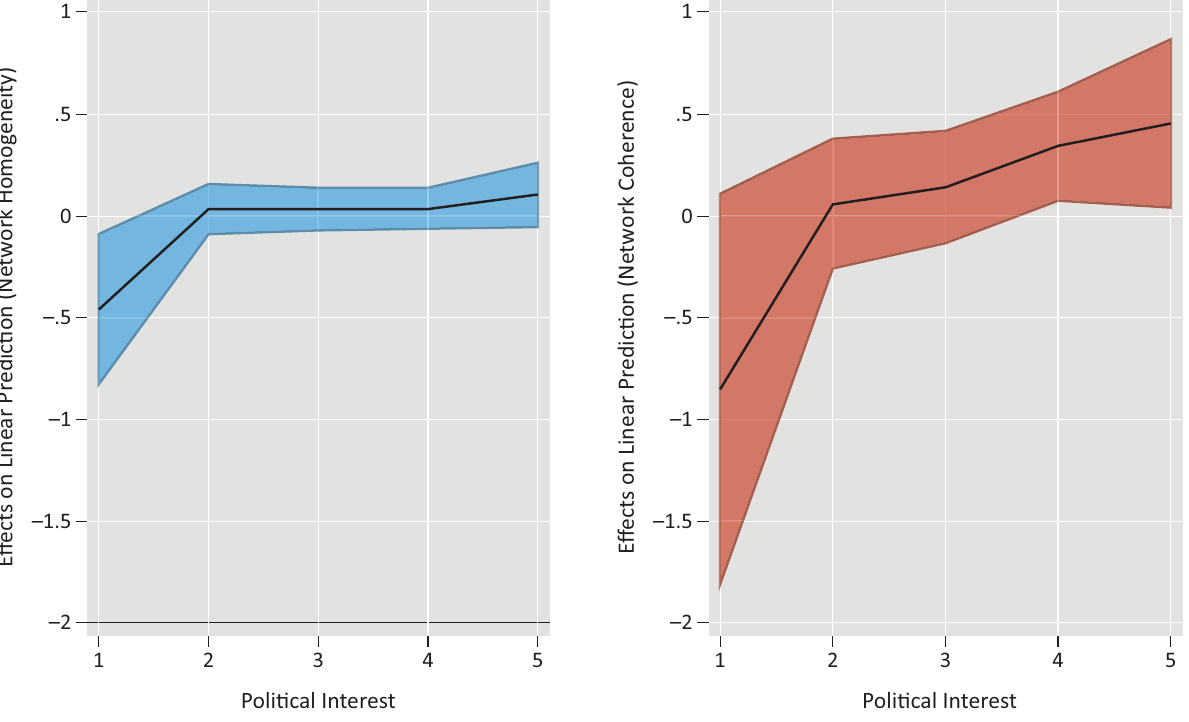
Figure 3. News congeniality effect on network homogeneity and coherence, across political interest. Notes: network ho- mogeneity is based on shared partisan affiliation between participants and alters. Network coherence is based on average ideological distance of a network from the participant. Both N =